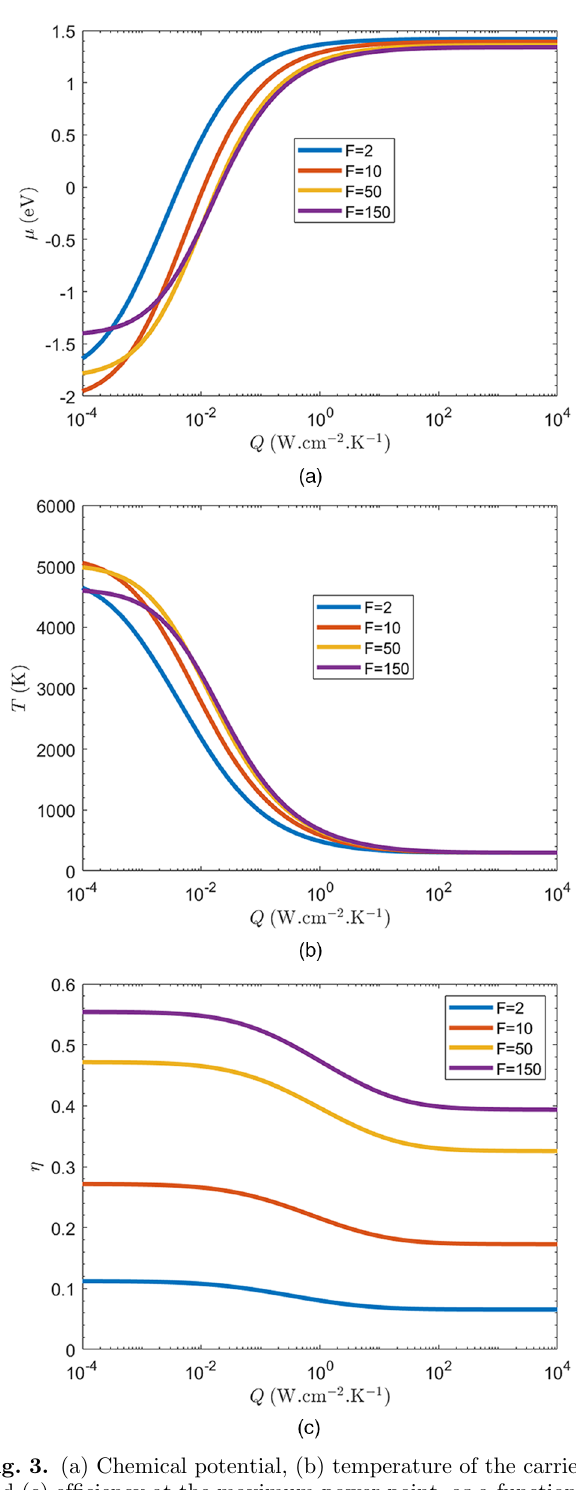
Fig. 3. (a) Chemical potential, (b) temperature of the carriers, and (c) ef fi ciency at the maximum power point, as a function of the thermalization coef fi cient Q , for different absorption